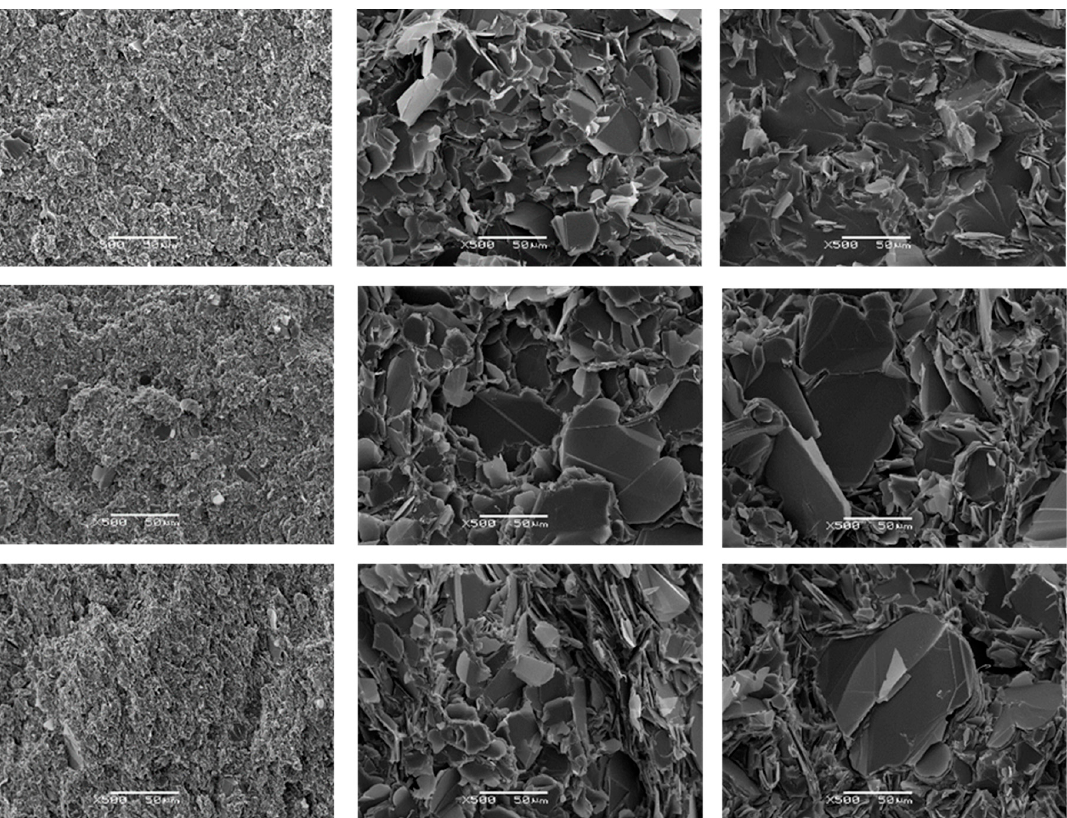
Figure 12. SEM micrographs of epoxy-thiol composites. Left hand column, top to bottom: ETLBN2 -30, -50, -60; middle column, top to bottom: ETLBN30 -30, -50, -60; right hand column, top to bottom: ETLBN180 -30, -50, -60. Magnification 500×, scale bar 50 μ m.